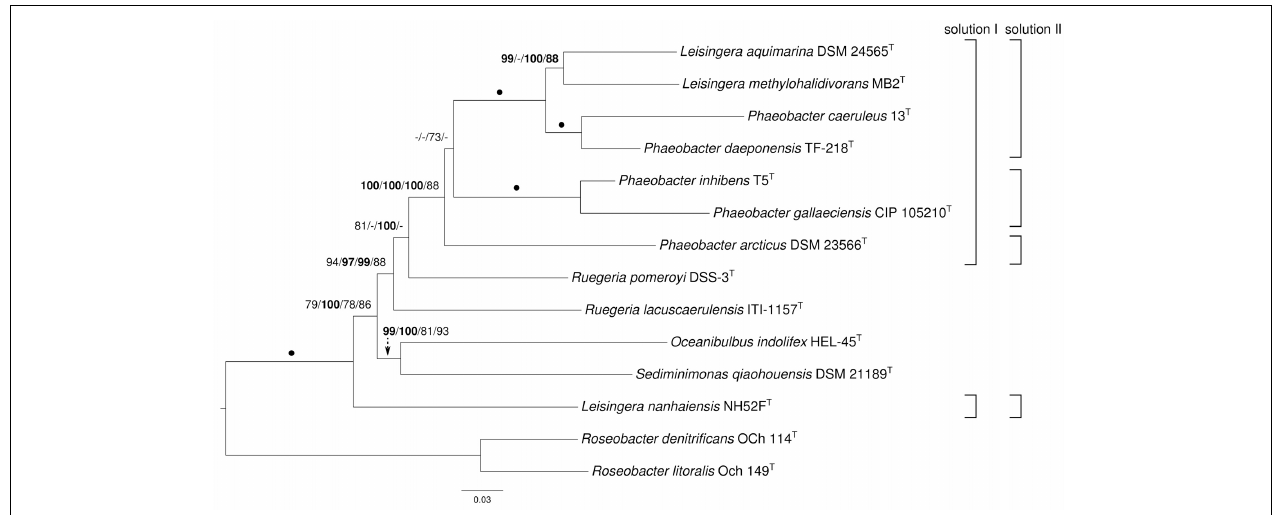
FIGURE 2 | Phylogeny inferred from the ortholog-content matrix under the maximum likelihood (ML) criterion and rooted with Roseobacter . The branches are scaled in terms of the expected number of substitutions per site. Numbers above the branches (from left to right) are bootstrapping support values (if larger than 60%) from (i) ML ortholog-content matrix; (ii)